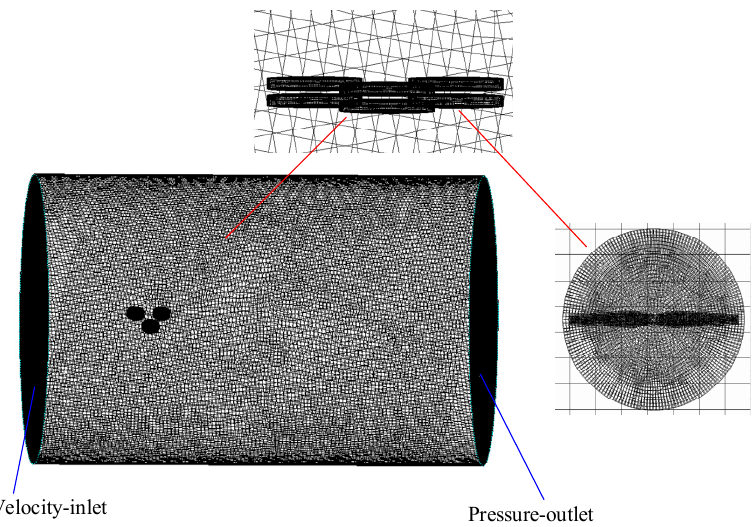
Figure 8. Mesh distribution.